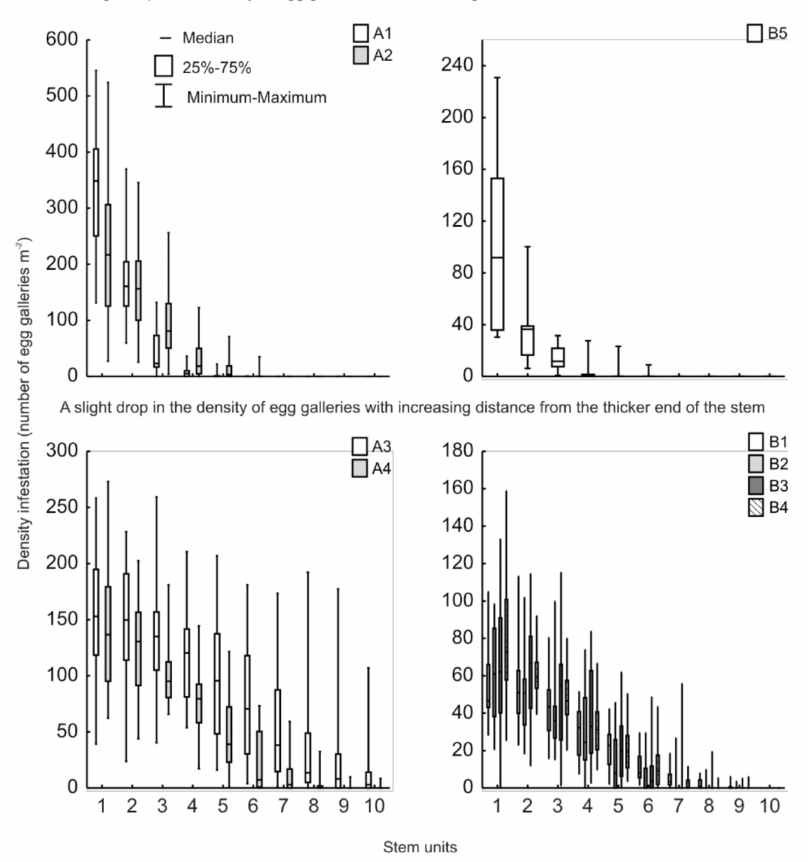
Figure 5. Colonization patterns of the trap logs units by T. piniperda . Tomicus minor was found most frequently in thinner parts of the stem; the density of egg galleries falls off more or less regularly with increasing distance from the unit with maximum colonisation. In conditions of low density of infestation of trap logs and low pine stand quality (stand B4), T. minor colonised the thicker part of stems exclusively (Figure 6). The results show that natural traps are an effective method of reducing pine shoot beetle populations, while a timber yard is a significant source of reproduction of T. piniperda